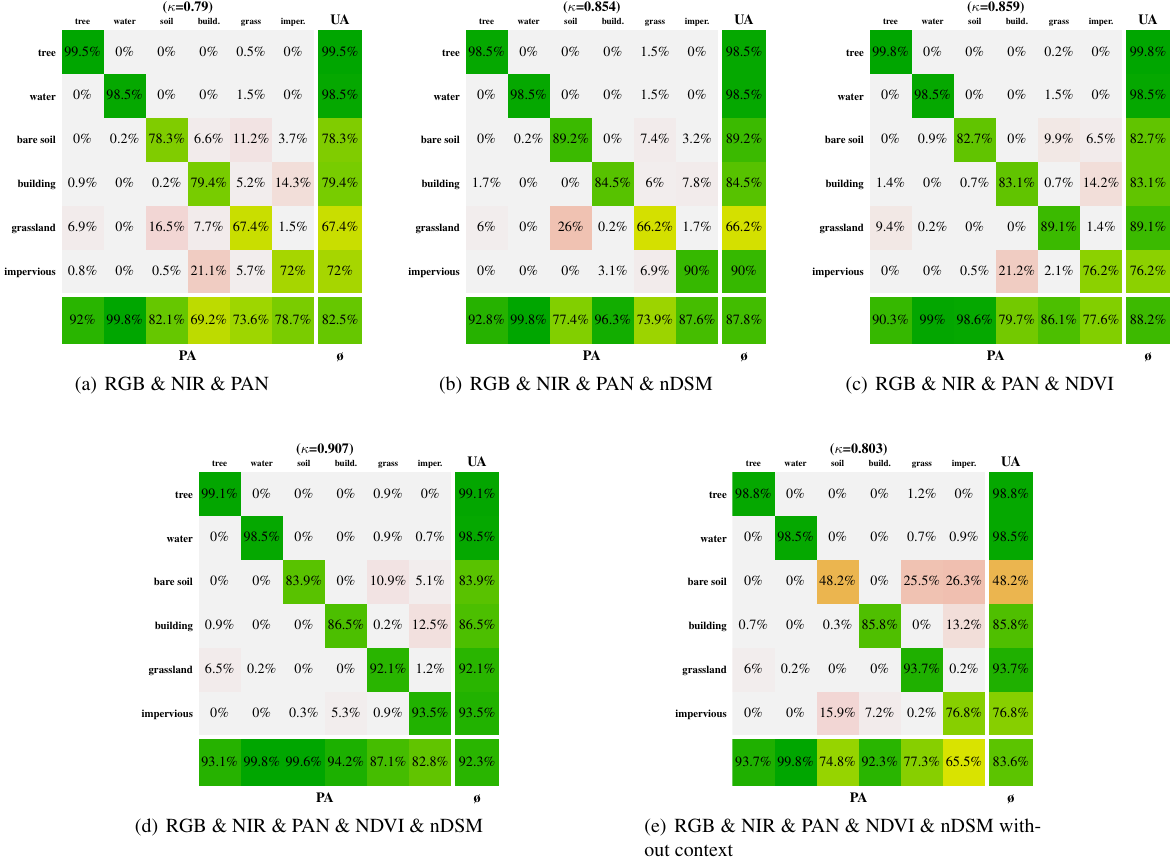
Figure 6: Results of ICF using different channels. RGB: red, green and blue channel, NIR: near infrared, PAN: panchromatic channel, NDVI: normalized differenced vegetation index, nDSM: normalized elevation model. UA: user accuracy and PA: producer